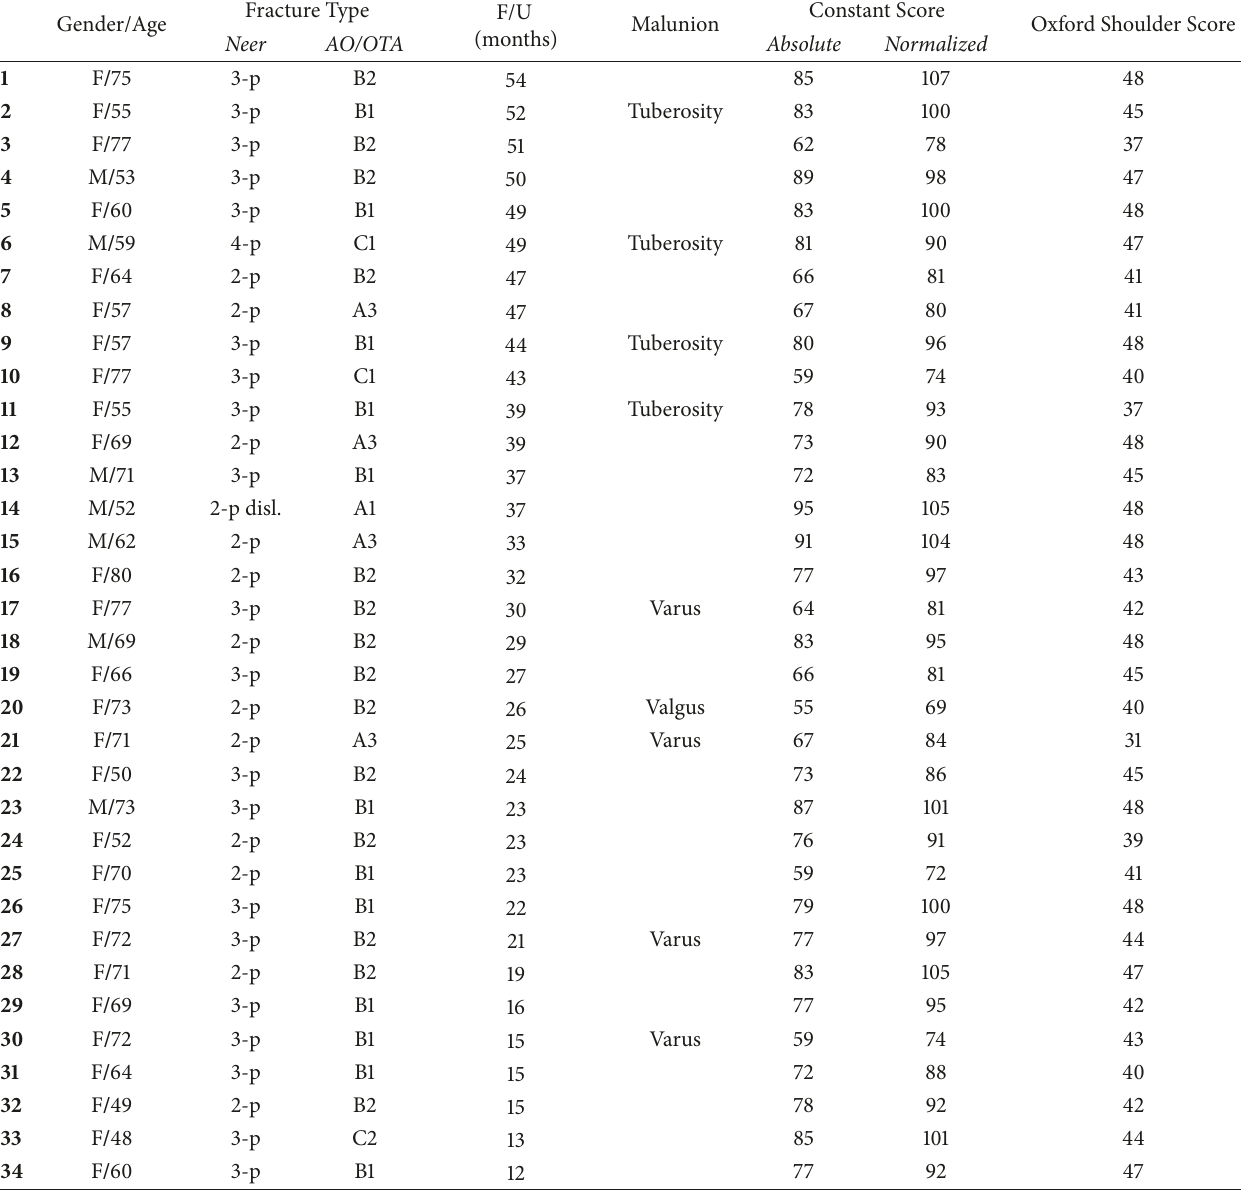
Table 2: Clinical data and outcome scores of patients evaluated at follow-up.